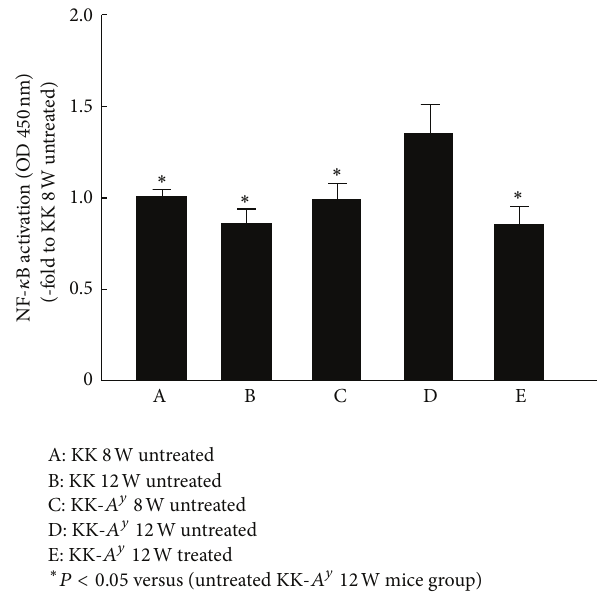
Figure 5: NF- 𝜅 B activation in each mouse (A: untreated KK mice at 8 weeks of age, B: untreated KK mice at 12 weeks of age, C: untreated KK- 𝐴 𝑦 mice at 8 weeks of age, D: untreated KK- 𝐴 𝑦 mice at 12 weeks of age, and E: treated KK- 𝐴 𝑦 mice at 12 weeks of age). The nuclear extracts were prepared and processed for the analysis of NF- 𝜅 B activation. The levels of NF- 𝜅 B activation were measured at OD450. These expressions were increased significantly in group 4 compared with groups 1, 2, and 3. This increase was attenuated in group 5 ( ∗ 𝑃 < 0.05 versus untreated KK- 𝐴 𝑦 mice at 12 weeks of